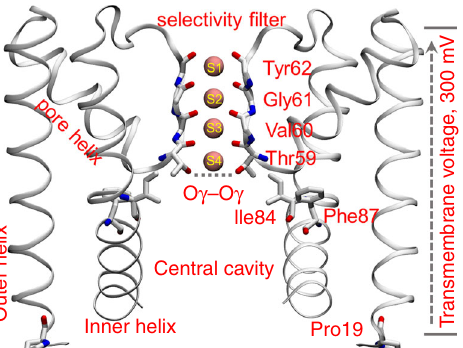
Fig. 1 Structure of the MthK pore domain. Only two subunits of the tetramer are shown for clarity. The four potassium-binding sites (pink dots) in the selectivity fi lter are labeled as S1 – S4. The distance between O γ atoms, the oxygen atoms of the Thr59 side chains, is depicted as the dashed line. Other residues that play a critical role in gating and ion permeation are labeled accordingly.